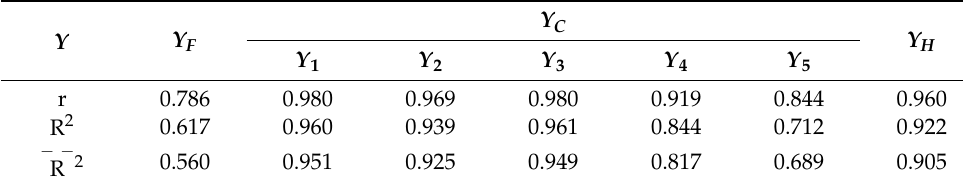
Table 4. Analysis of fitting